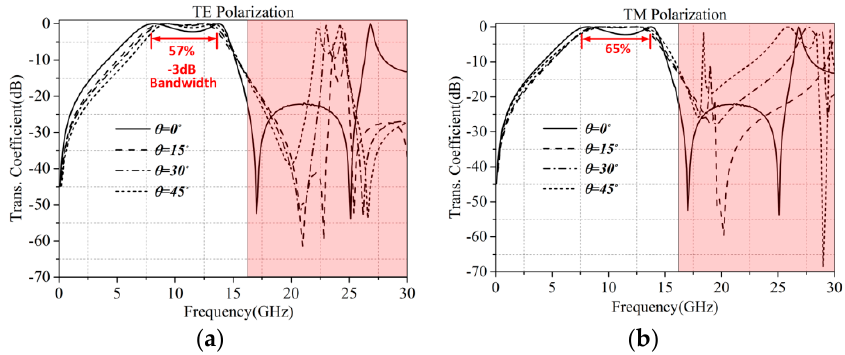
Figure 2. Transmission coefficient characteristics for oblique incidences on the non-resonant FSS for ( a ) Transverse Electric (TE) polarization and ( b ) Transverse Magnetic (TM) polarization (The red shadow represents harmonic transmission bands).